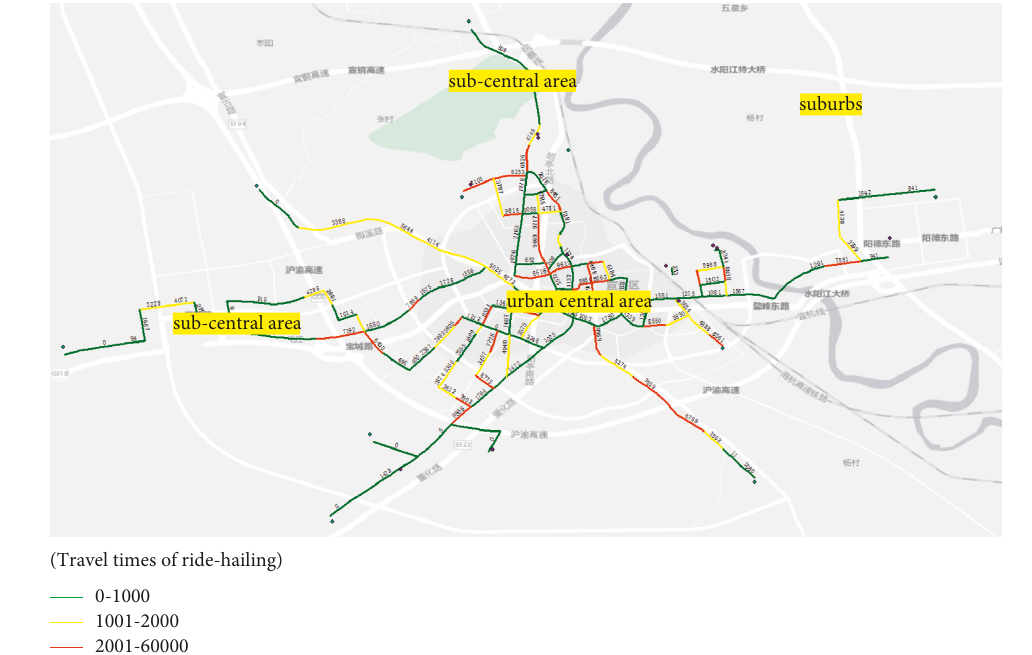
Figure 10: Data distribution of travel times of ride-hailing vehicles on bus routes. Table 6: Average ratios of different kinds of vehicles on congested road sections. Road Average Start time End time section ID